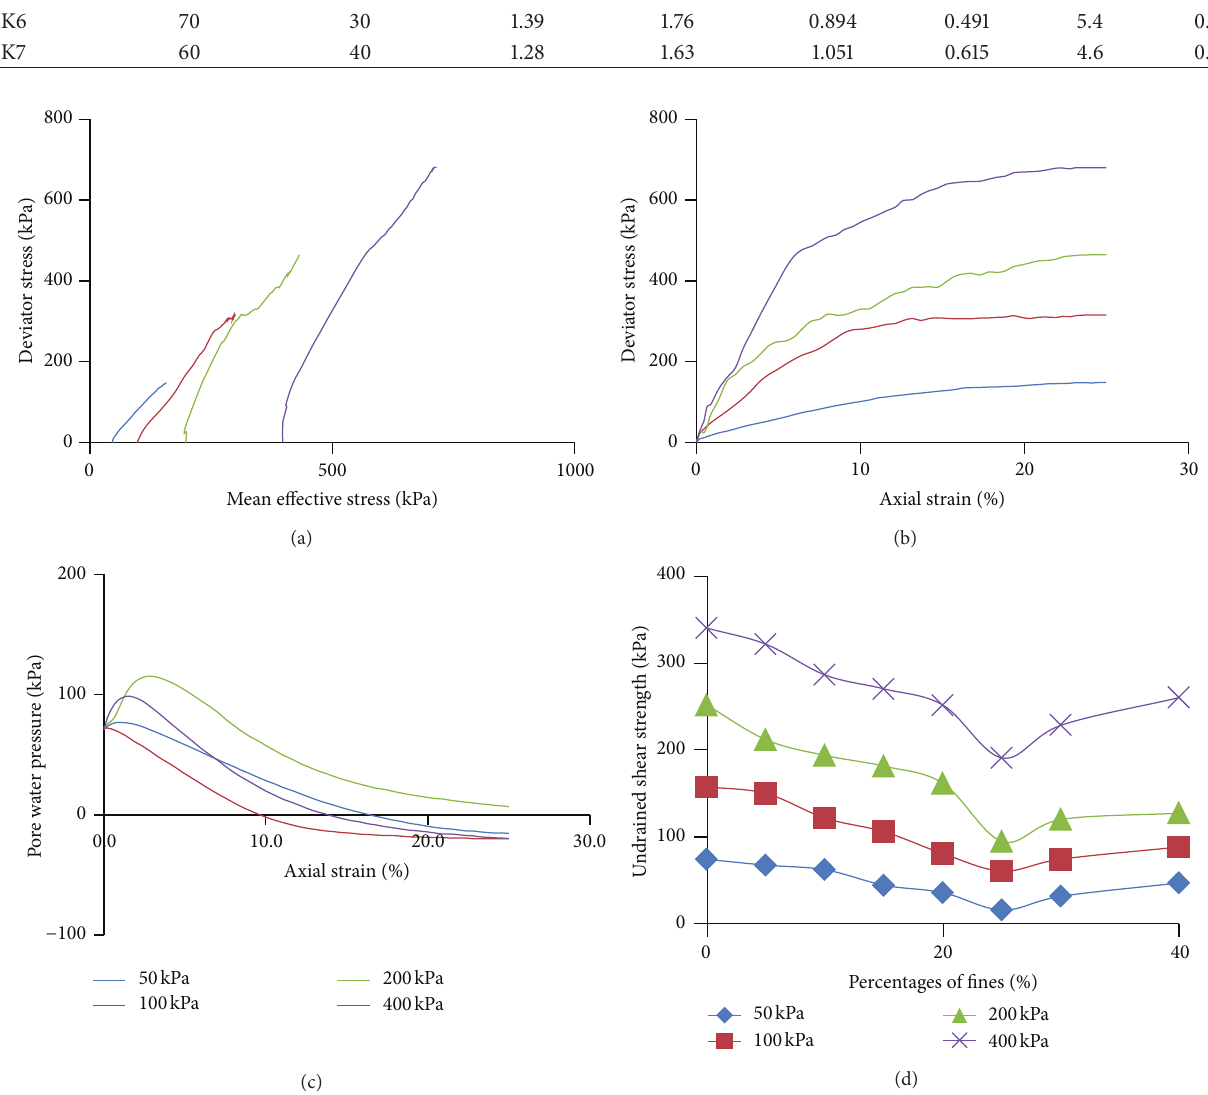
Figure 3: (a) Stress path; (b) peak deviator stress; (c) pore pressure developments; (d) undrained shear strength of tested sand matrix